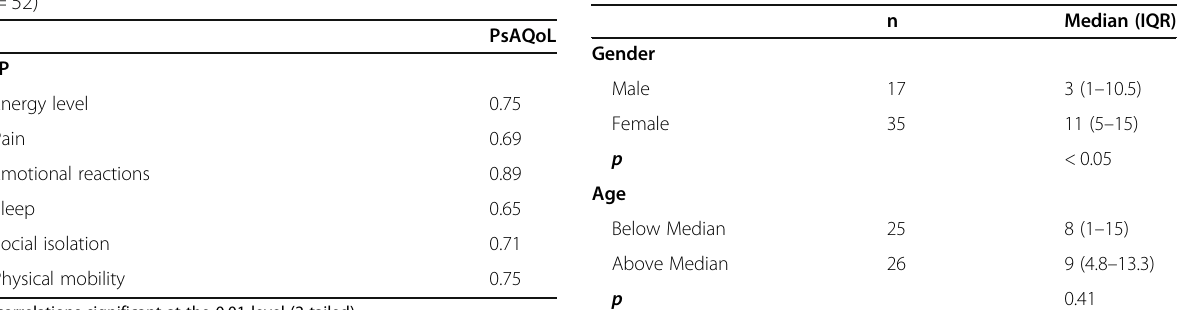
Table 4 Median PsAQoL scores by demographic